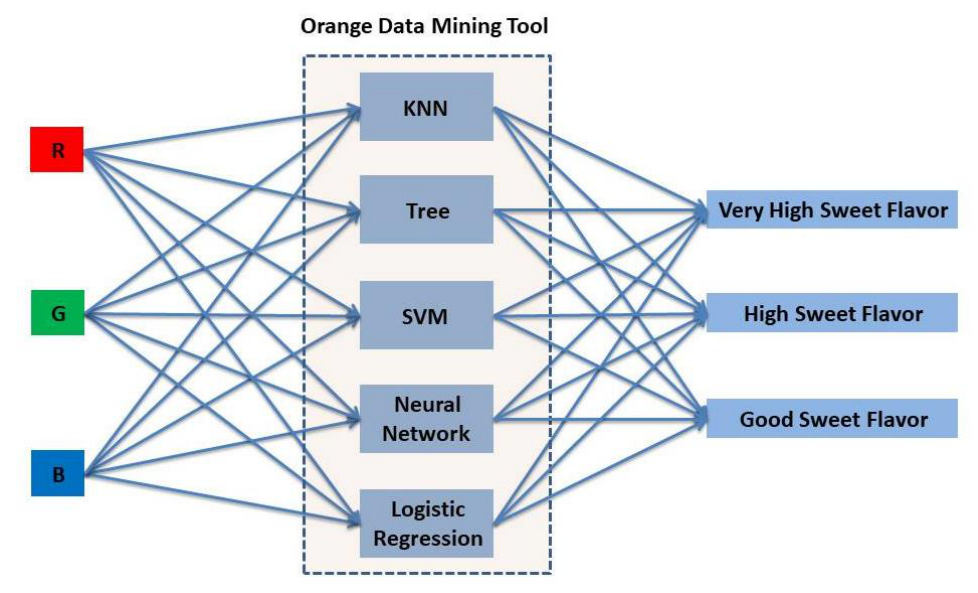
Figure 4. The sweetness prediction structure diagram.